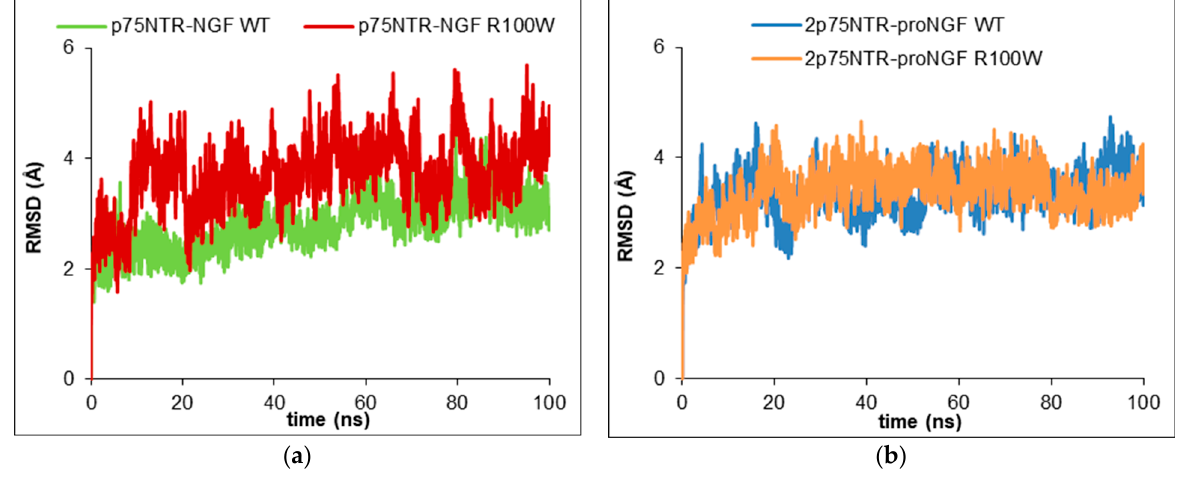
Figure 2. Root-mean-square deviation plots of the complexes: ( a ) p75NTR/NGF and ( b ) 2p75NTR/proNGF.